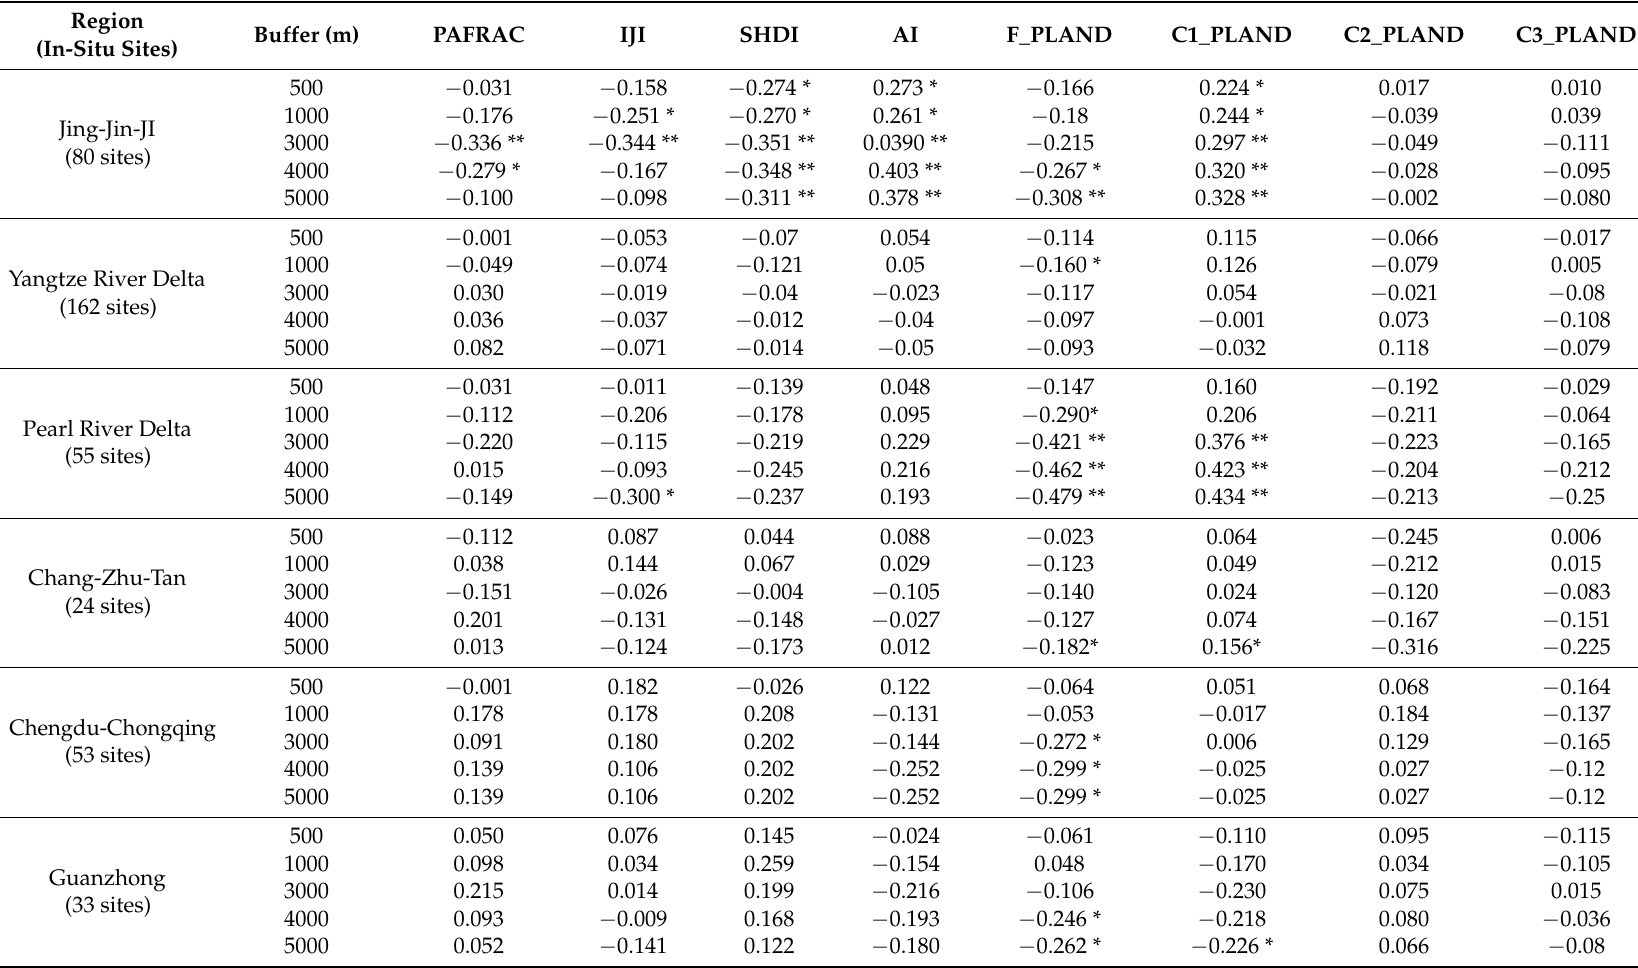
Table 1. Correlation between landscape indices with PM 2.5 at different buffers (500, 1000, 3000, 4000, and 5000 m) of the in situ site in the six urban agglomerations. Region (In-Situ